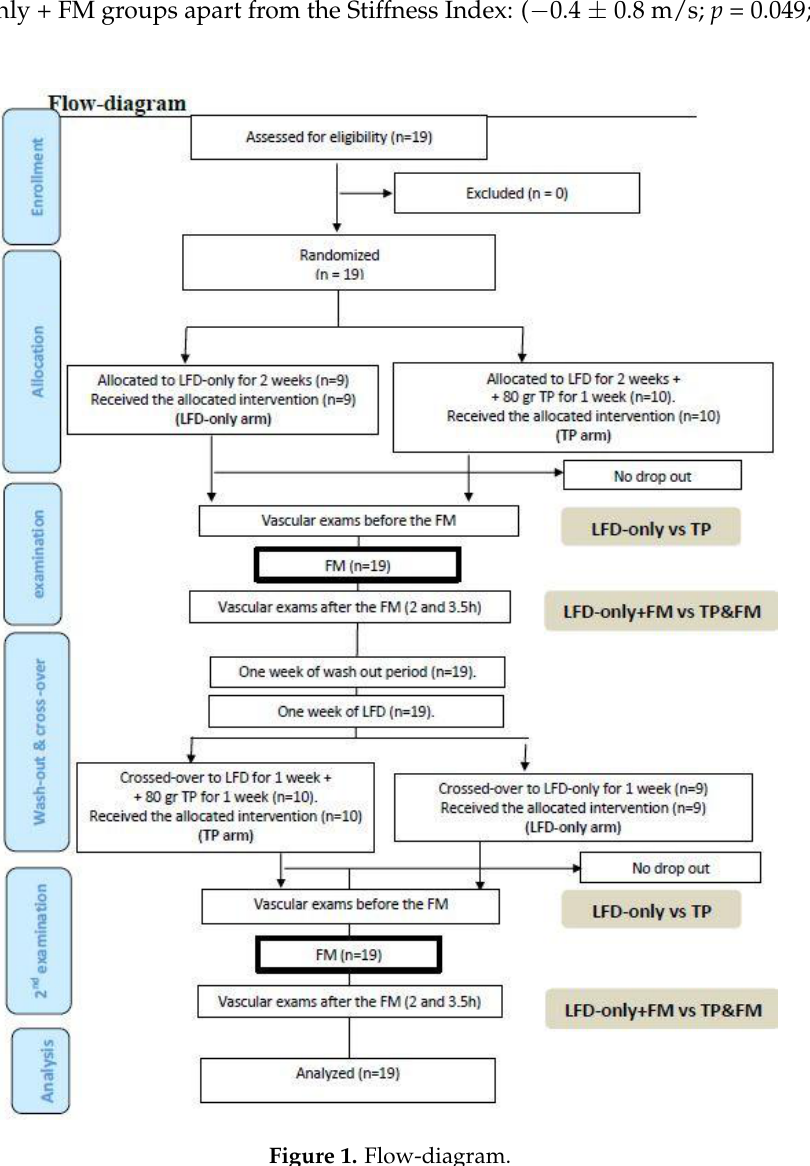
Figure 1. Figure1. Flow-diagram.